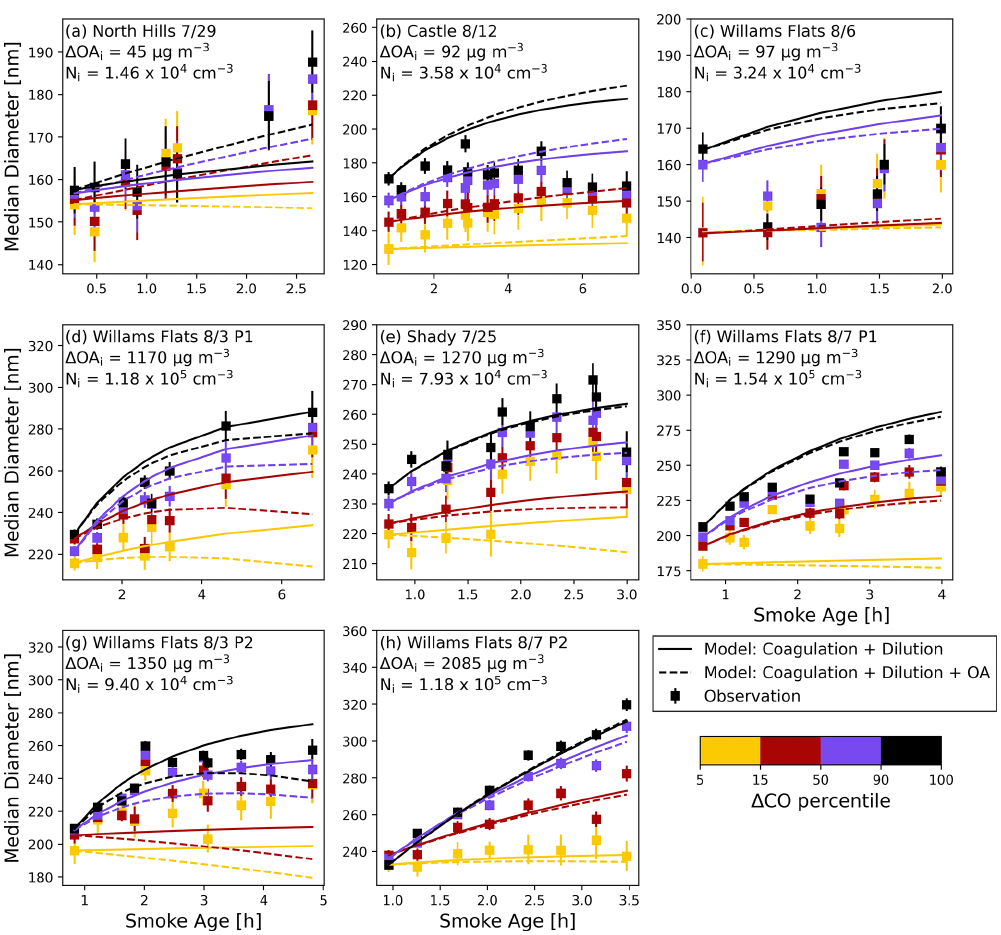
Figure 8. The observed (points), coagulation modeled (solid line), and coagulation plus changes due to OA evaporation/condensation (dashed line) median diameter as a function of smoke age for each of the eight smoke plumes used in our analysis colored by (cid:49) CO percentile. Shown inset is the (cid:49) OA measured at the first transect ( (cid:49) OA i ) in µgm − 3 , and the aerosol number concentration of particles greater than 100nm measured at the first transect ( N i ) (cm − 3 ). The error bars represent the standard deviation of D p within the transect. Panels (a) – (h) are in order of increasing initial (cid:49)